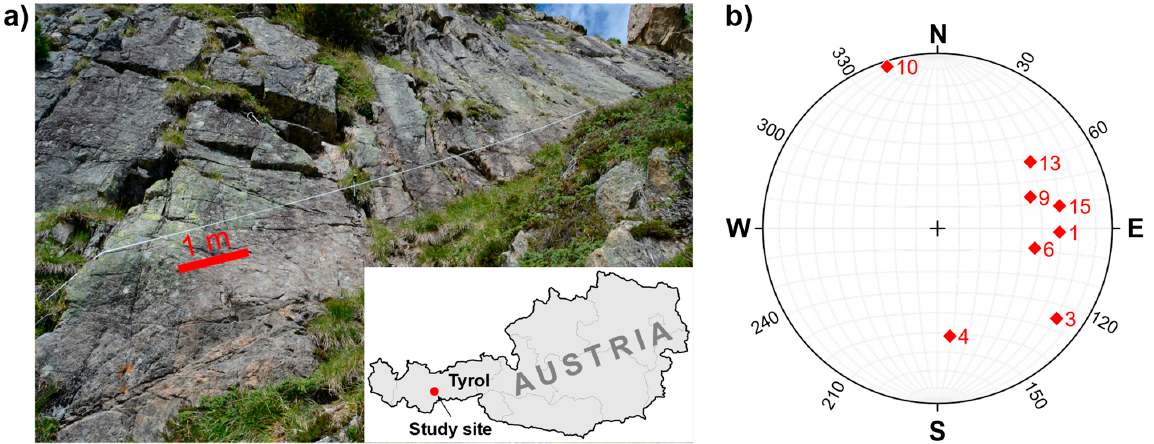
Figure 3. ( a ) Granodioritic rock face with fixed scanline tape, and ( b ) trend and plunge of the eight scanlines labeled as 1, 3, 4, 6, 9, 10, 13 and 15. Pole plots were created using the software Stereonet [37,39].